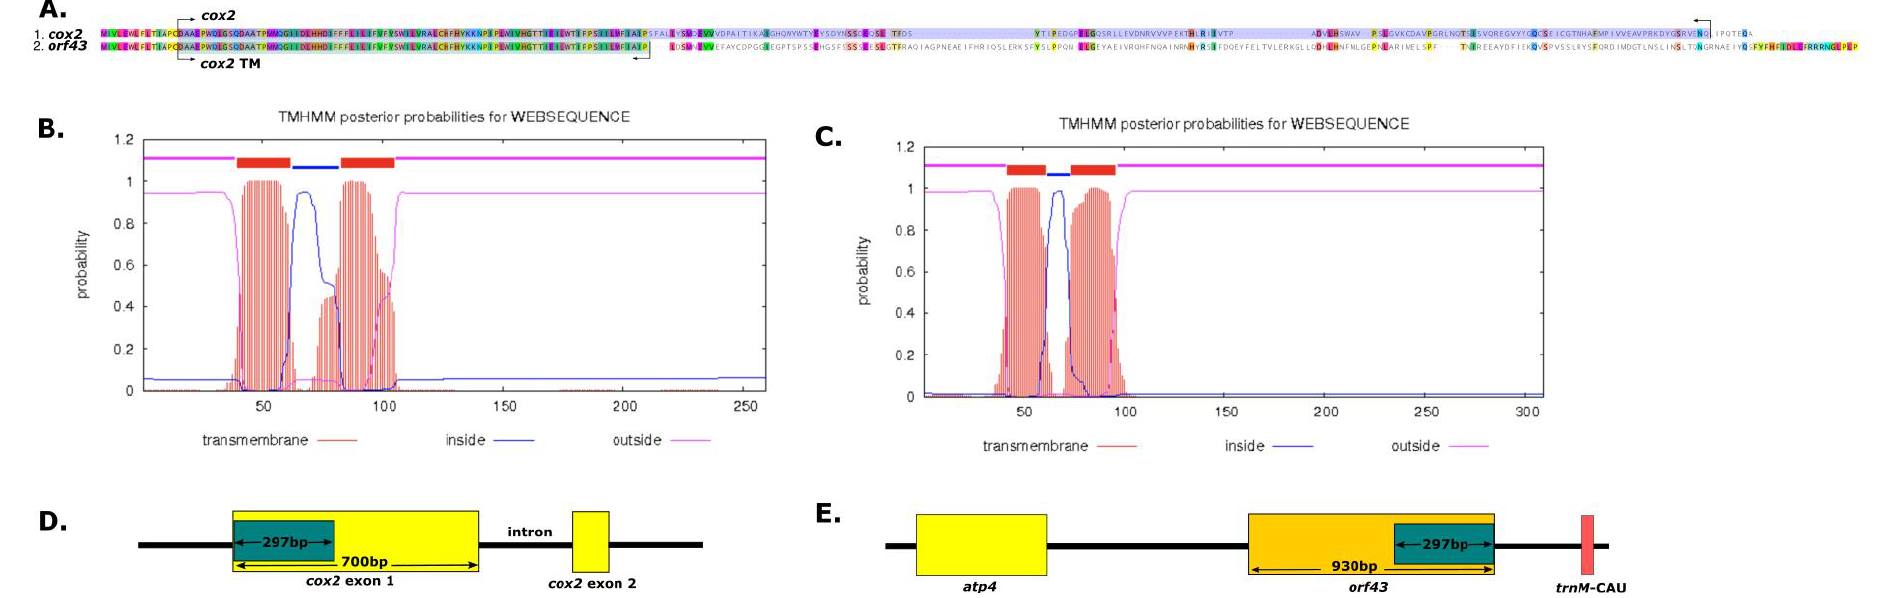
Figure 4. Comparison of cox2 and orf43 encoded proteins and prediction of transmembrane helices. ( A ) Comparison of the amino acids coded by cox2 and orf43 . ( B ) Prediction of transmembrane helices coded by cox2 . ( C ) Prediction of transmembrane helices coded by orf43 . ( D ) Location of the cox2 gene in the A. indica mitogenome. (E) Location of the orf43 gene in the A. indica mitogenome. Small repeats that generate chimeric portions in the cox2 xon1 and orf 43 are shown in green ( D , E ). The arrow indicates each length.